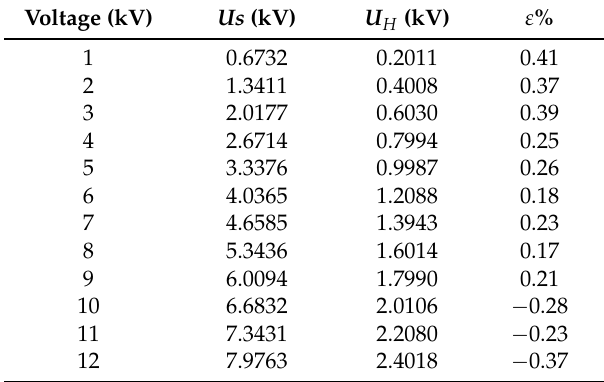
Table 7. Results of Phase B.